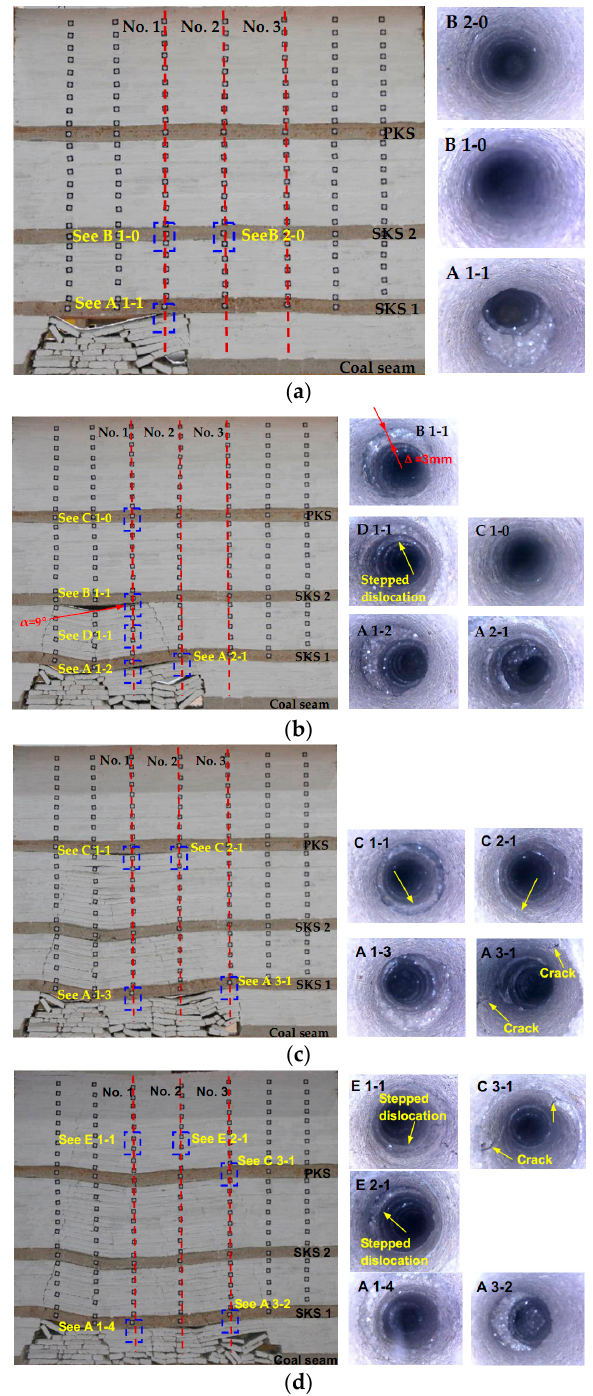
Figure 8. The observation results of the strata movement and borehole deformation with coal seam mining. ( a ) Working face advanced past the 1# borehole at a distance of 70 mm; ( b ) Working face advanced past the 2# borehole at a distance of 110 mm and the SKS 1 experienced its first breaking; ( c ) Working face advanced past the 3# borehole at a distance of 30 mm and the SKS 2 experienced its first breaking; ( d ) Working face advanced past the 3# borehole at a distance of 240 mm and the PKS experienced its first breaking.